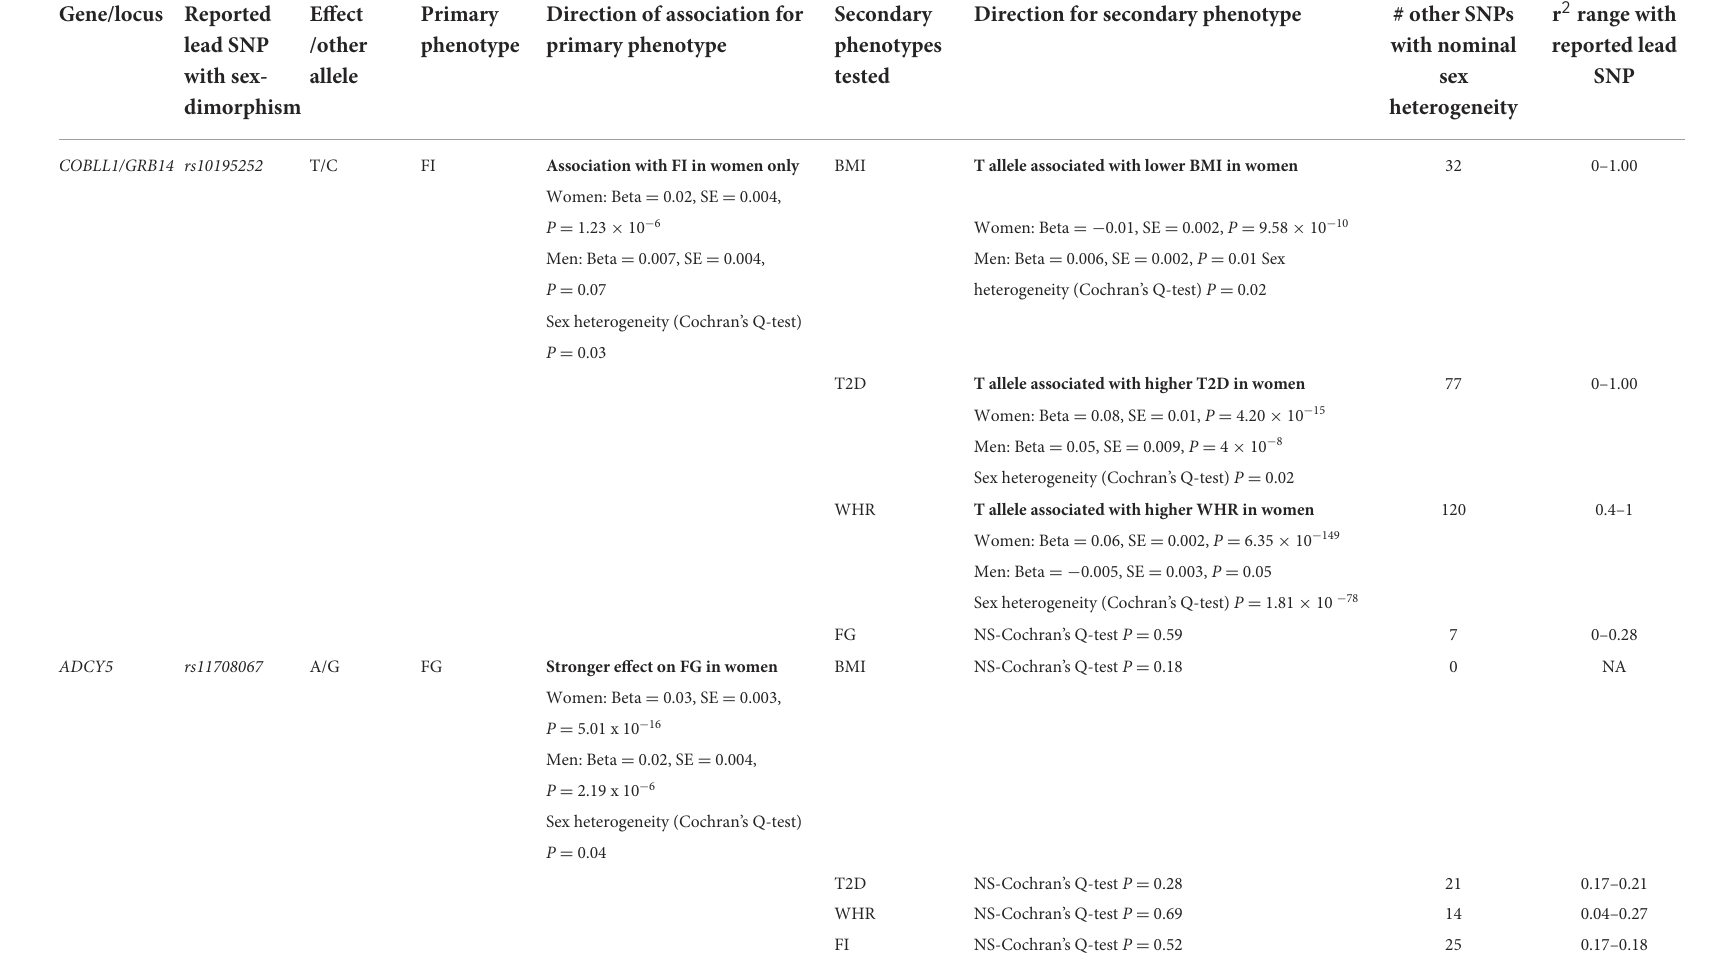
TABLE 1 Associations of sex dimorphic effects of most important genes identified to date on type 2 diabetes and related phenotypes. Gene/locus